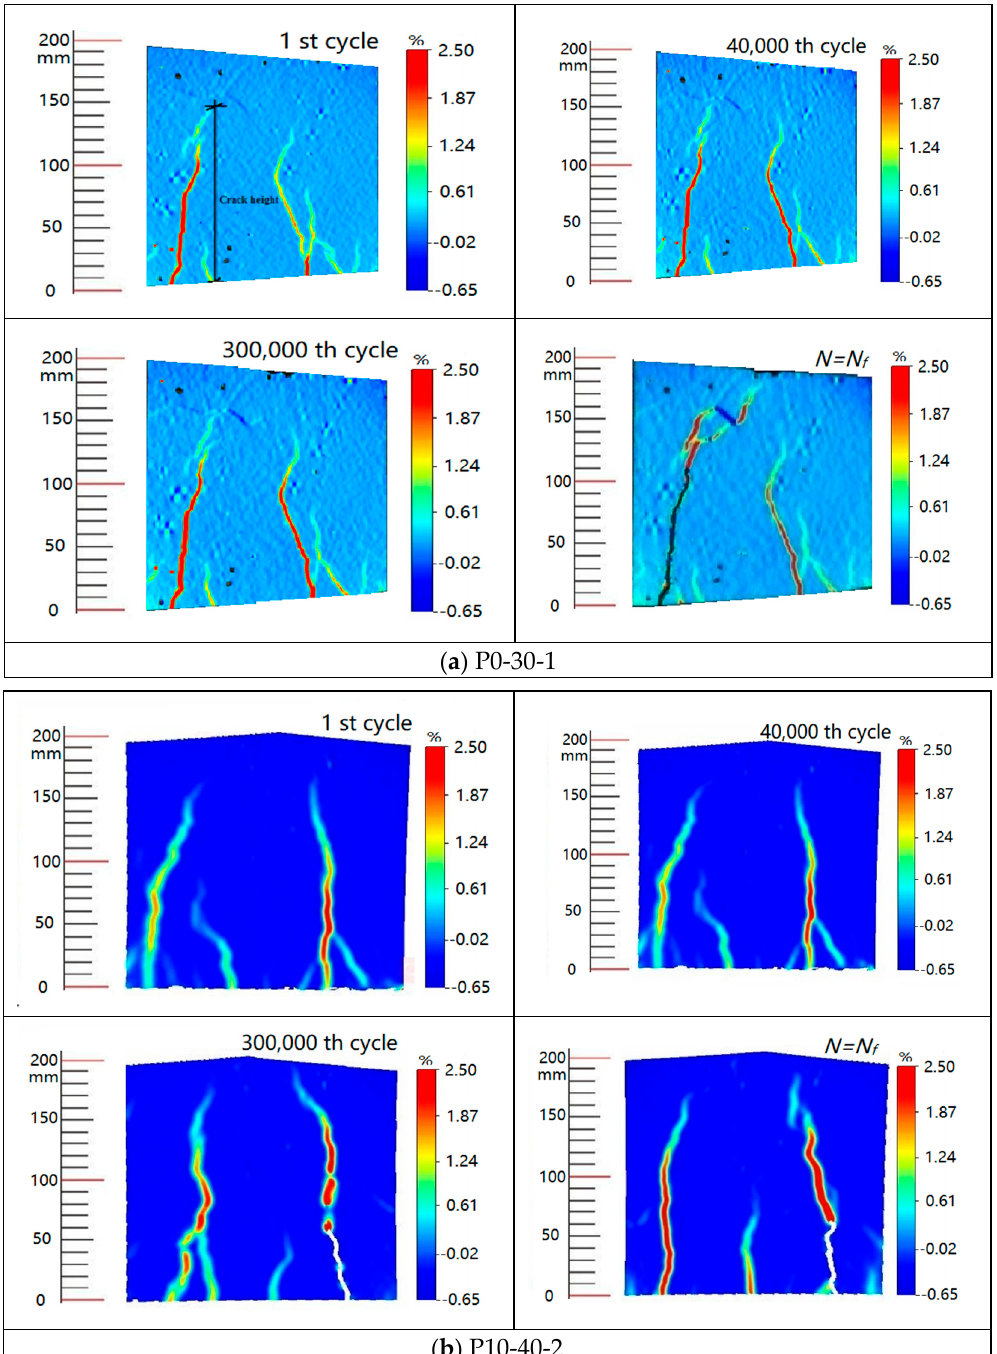
Figure 10. Crack pattern evolution at different loading cycles. ( a ) P0-30-1; ( b ) P10-40-2.